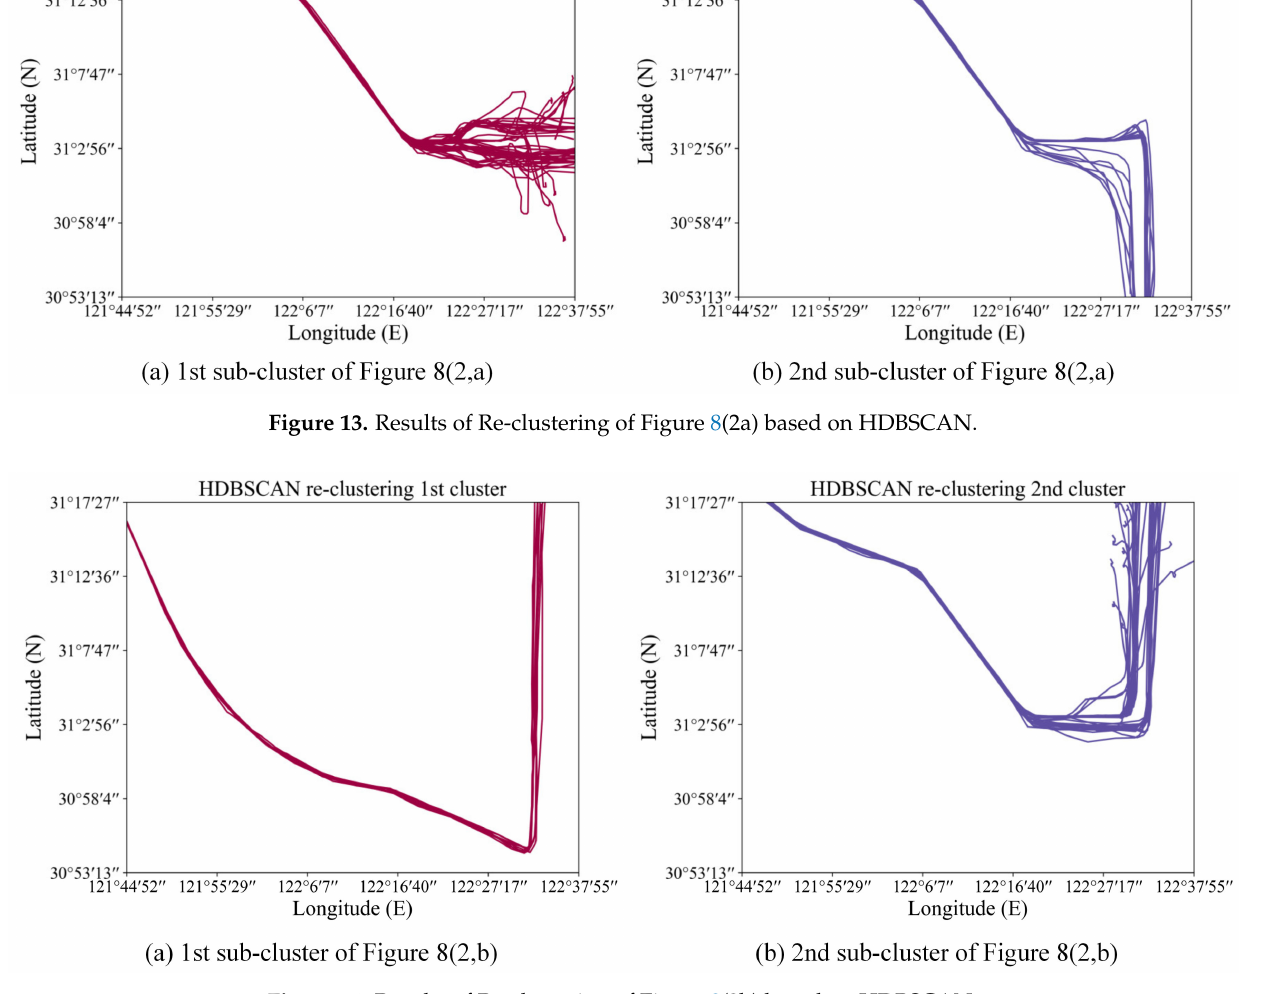
Figure 14. Results of Re-clustering of Figure 8(2b) based on